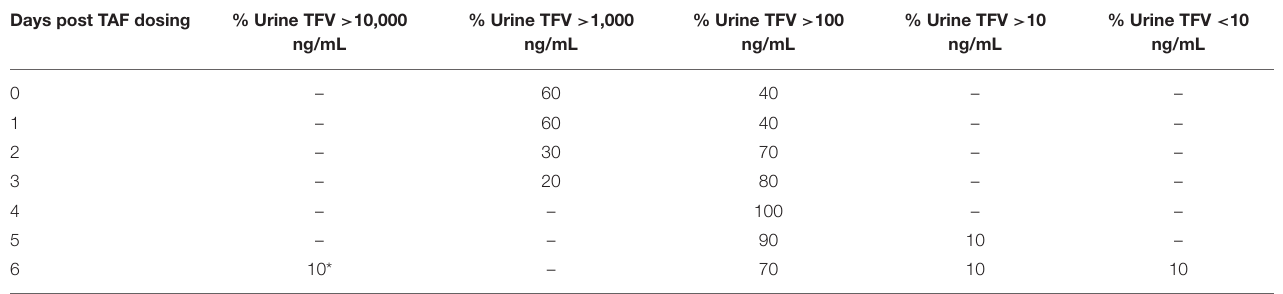
TABLE 2 | Observed urine concentrations from the single dose cohort. Days post TAF